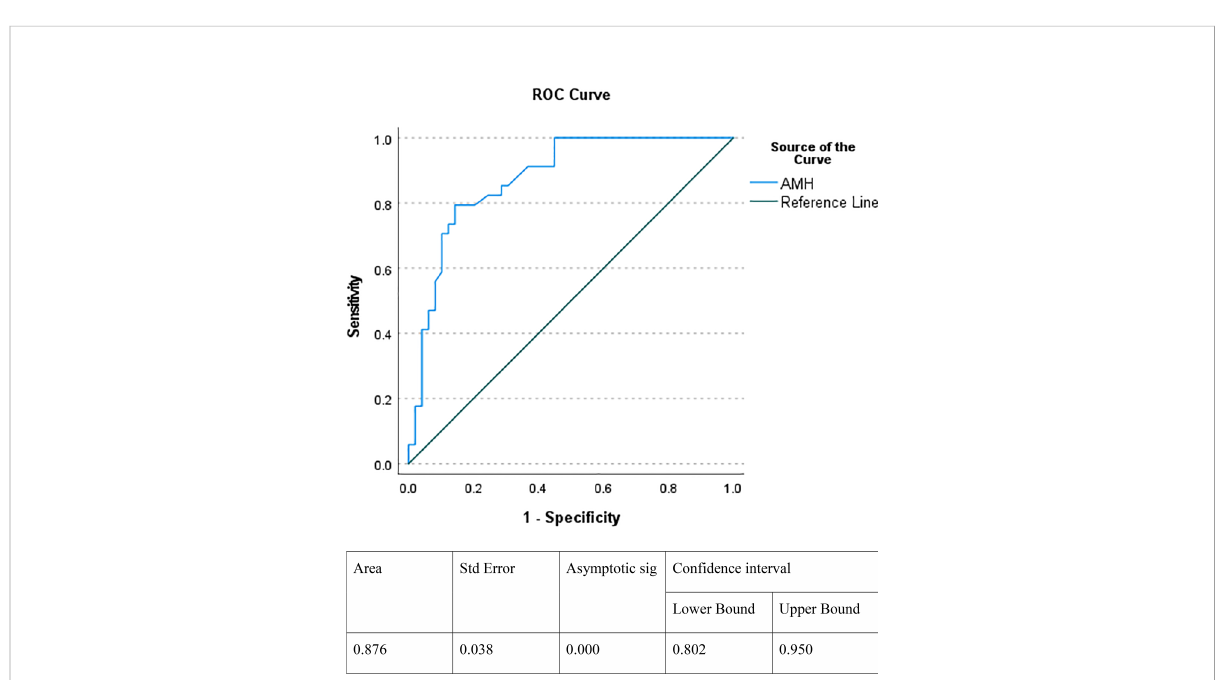
FIGURE 2 ROC curve indicating the speci fi city and sensitivity of AMH in detecting functioning testicular tissue. AMH, antimullerian